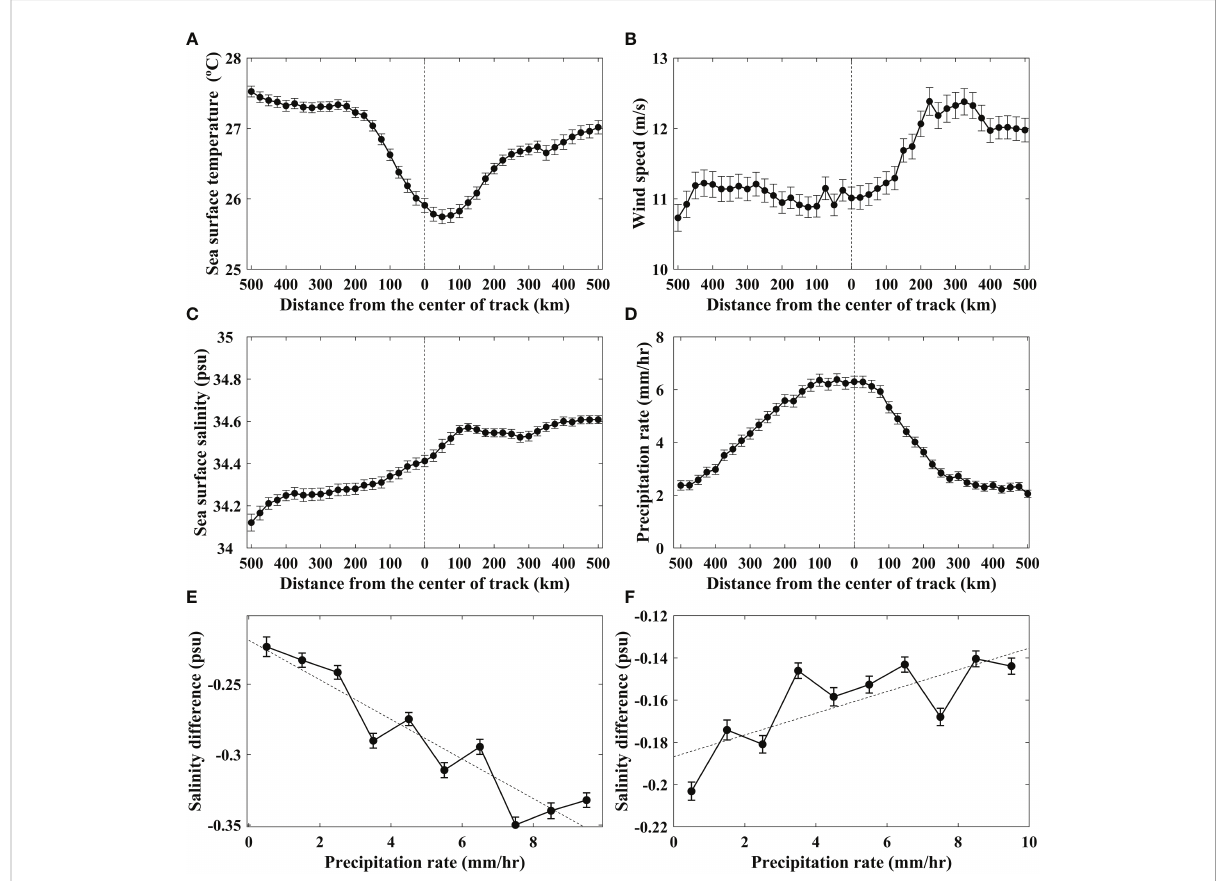
FIGURE 13 Distributions of (A) SST (°C), (B) wind speed (m s -1 ), (C) salinity (psu), and (D) precipitation rate (mm h -1 ) as a function of distance from a typhoon center in the Northwest Paci fi c. SSS difference (SMAP – Argo) as a function of the maximum precipitation rate over time in (E) the left and (F) right side of each typhoon, where the error bar represents a mean error ( s = interval, and the dashed line represents a least-squared linear fi